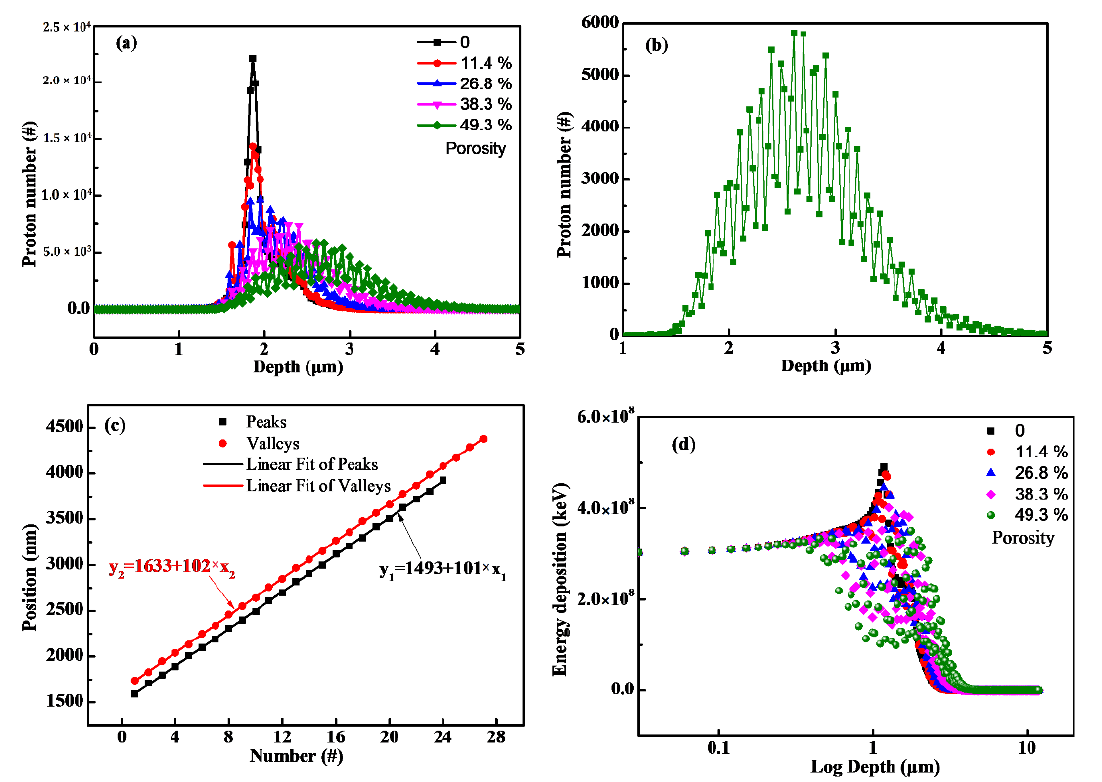
Figure 4. ( a ) The relationship between proton distribution and porosity (the radius of the voids was set as 50 nm, and the distance between the adjacent voids was set as 102 nm, 111 nm, 125 nm and 166 nm, respectively); ( b ) a zoom view of 49.3% porosity in ( a ); ( c ) the position of peaks and valleys as a function of number; ( d ) the relationship between energy deposition and porosity.